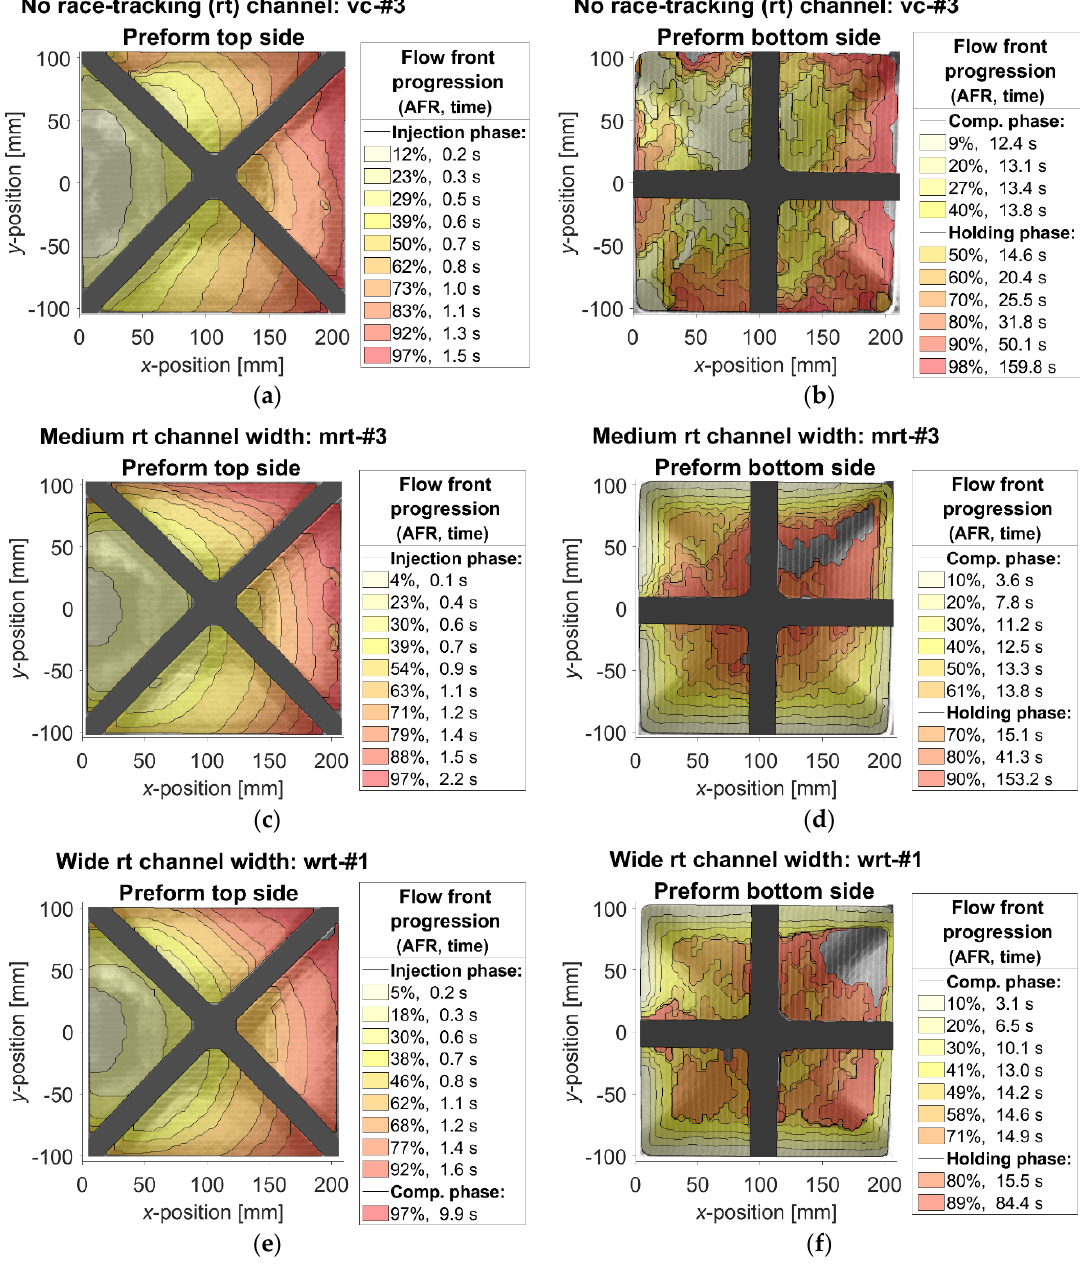
Figure 7. Flow front progression of FS-CRTM experiments of the race-tracking study: ( a , b ) no race-tracking (rt) channel— vc-#3; ( c , d ) medium race-tracking channel width—mrt-#3; ( e , f ) wide race-tracking channel width—wrt-#1 (AFR = area filling ratio).